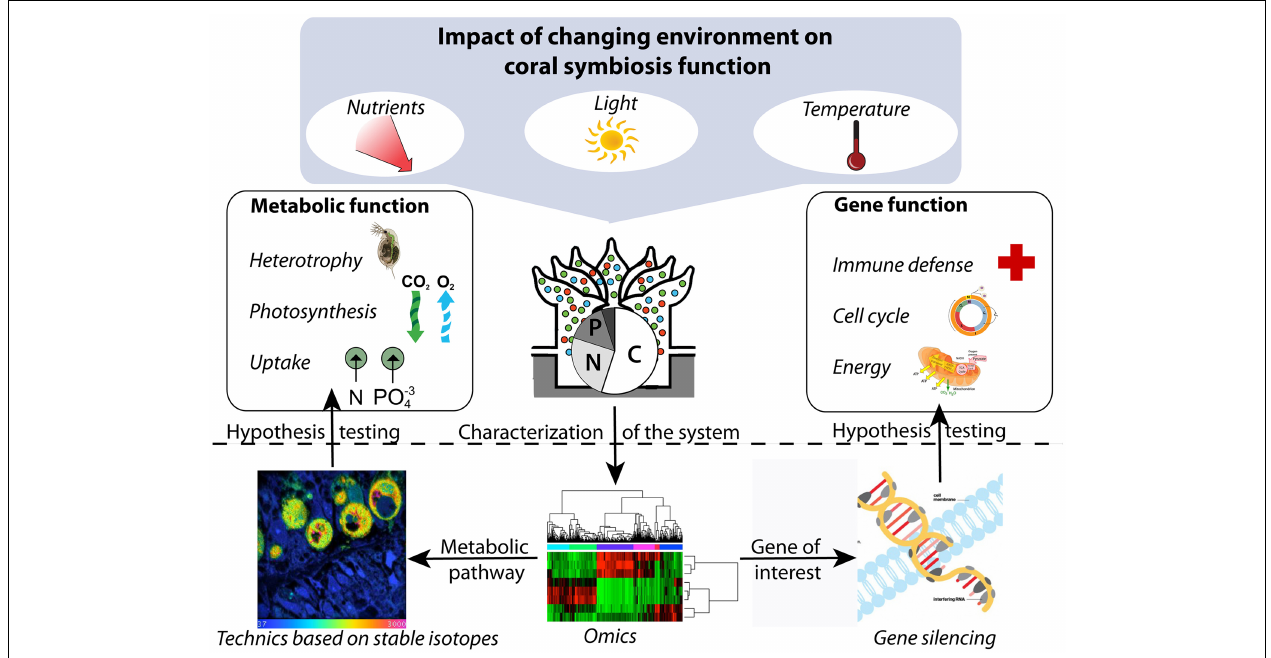
FIGURE 1 | Conceptual framework integrating metabolic and gene function to study the impact of the environment on coral symbiosis. The “omics” approaches can be used to describe the system under different